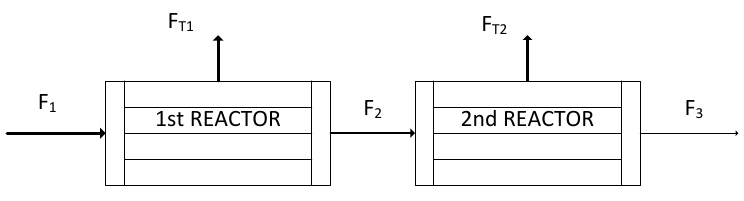
Figure 9. Series of multi-tube membrane modules.